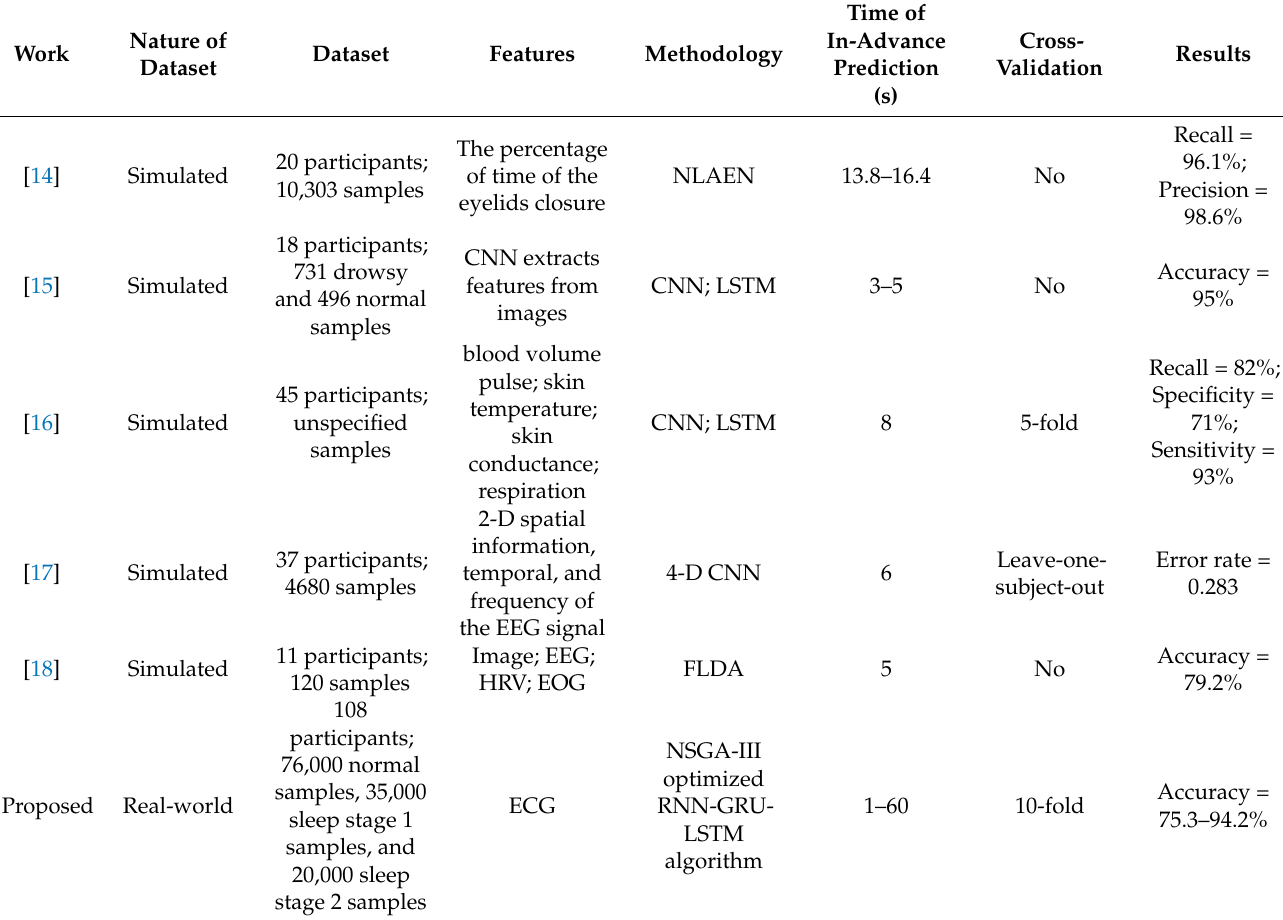
Table 6. Comparison between the proposed algorithm and existing works for driver drowsiness